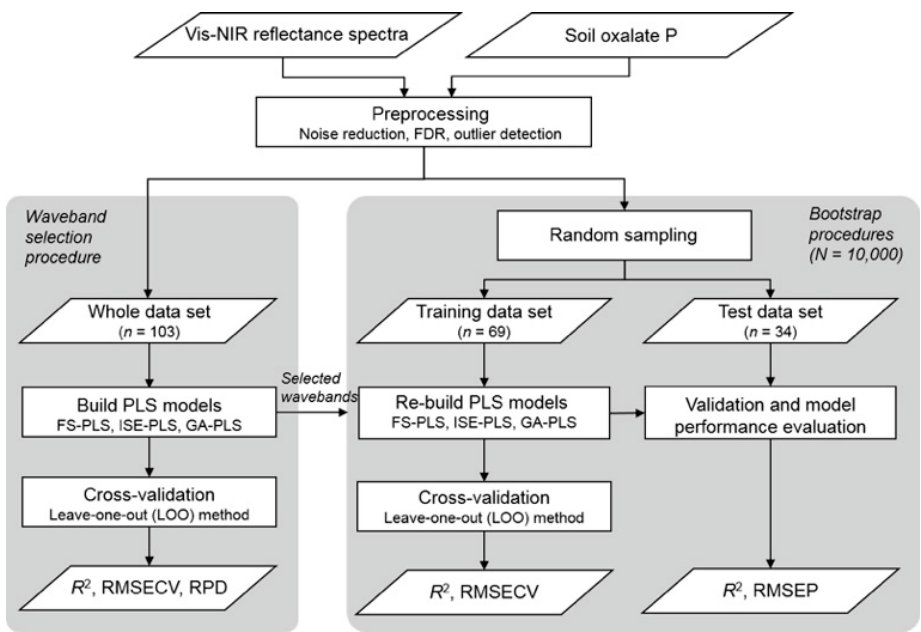
Figure 2. Flowchart depicting a general overview of the methodology.